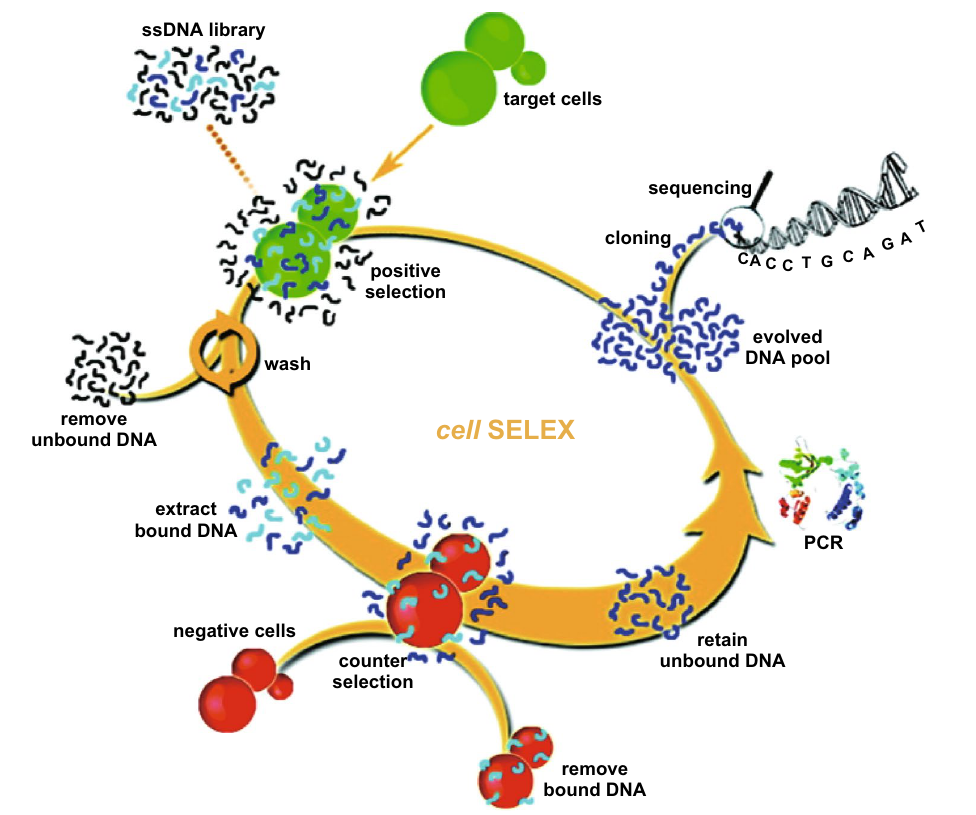
Fig. 12 Schematic representation of the cell-SELEX approach for aptamer selection. Reproduced with permission from Ref. [139]. Copyright 2009, American Chemical